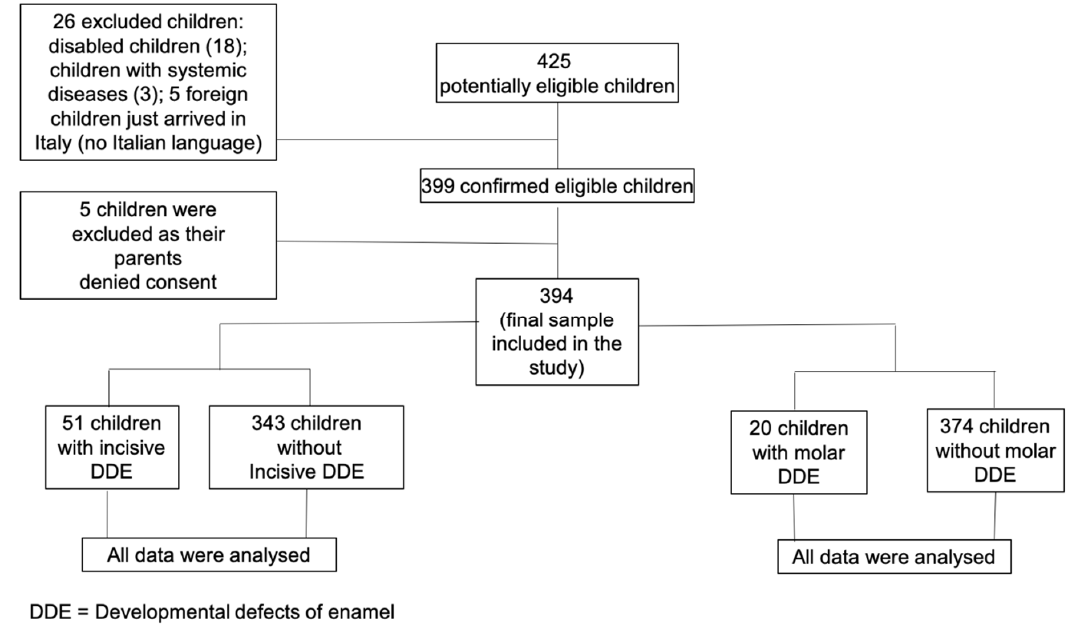
Figure 1. Study flow chart.